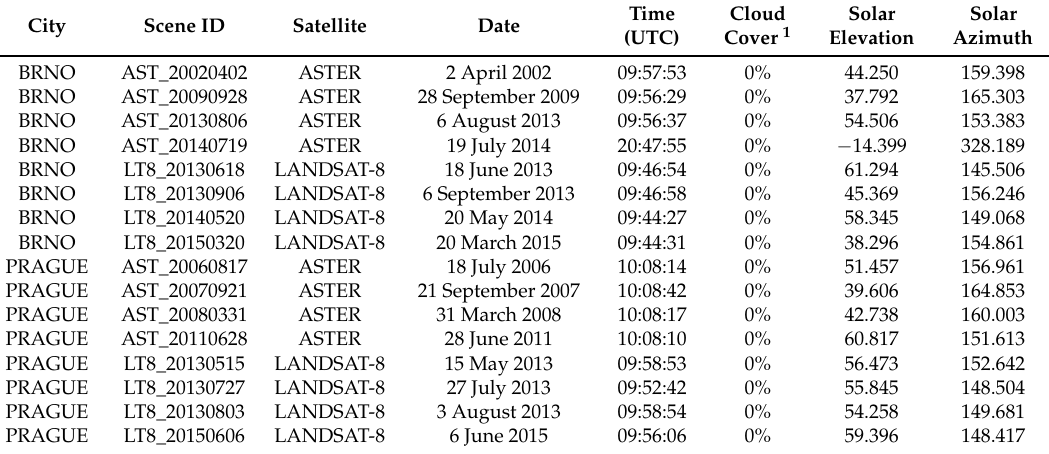
Table 3. Satellite imagery used for local climate zone (LCZ)